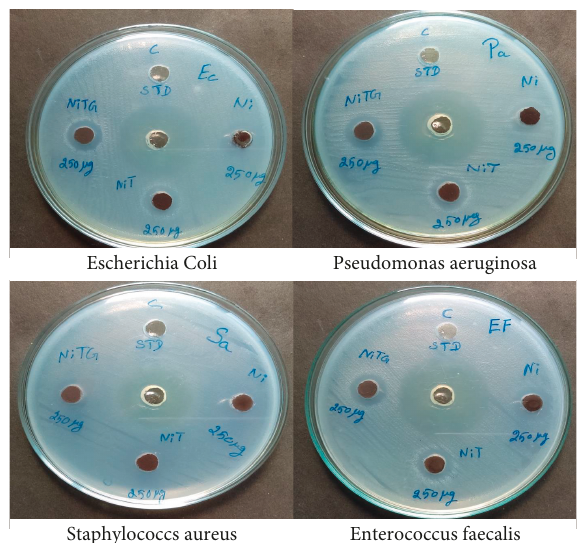
Figure 14: Zone of inhibition against Gram-positive and Gram-negative bacteria in well diffusion method. Table 5: Zone of inhibition against Gram-positive and Gram-negative bacterial strains in well diffusion method.